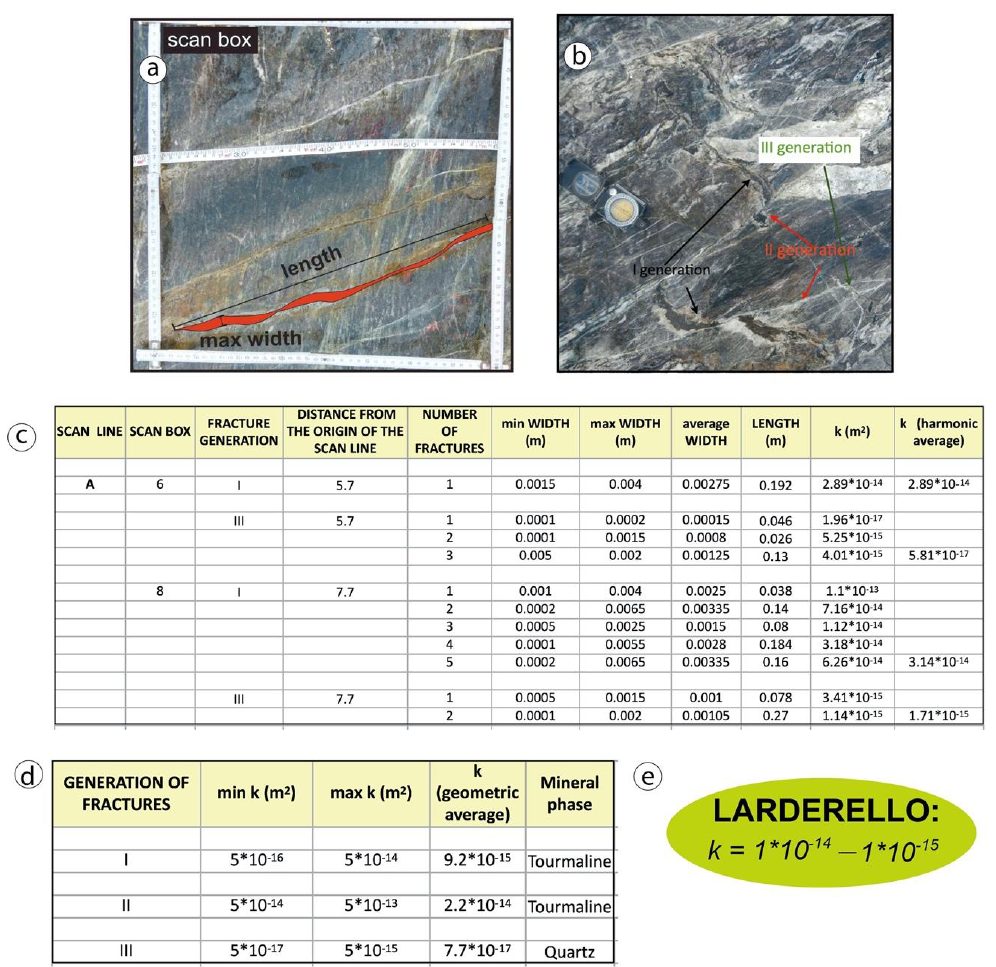
Figure 9. How to get permeability values in the field: ( a ) photo illustrating the scan box and the parameters to be collected; ( b ) in the study area, three different generation of mineralized veins have been recognized; ( c ) example of collection of data and related database; ( d ) values of permeability, after having considered the average among all the data; ( e ) data of permeability measured in the active geothermal field of Larderello, for comparison with the obtained data; after Reference [69]. The asterisk indicates the multiplication sign.